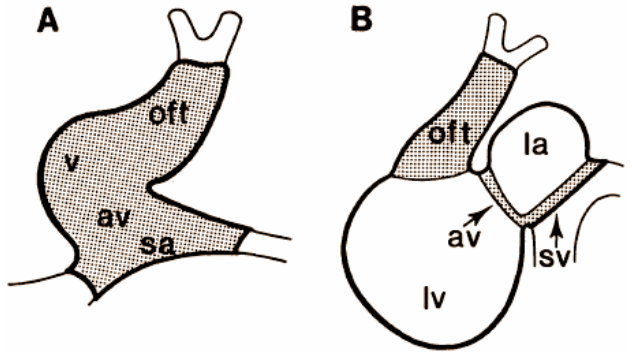
Figure 3. Slow and fast conducting regions. Alternating regions of slow and fast conduction in the looping heart of the chicken embryo detected using electrodes [38]. ( A ) The conduction velocity of the HH stage 13 (embryonic day 2) early looping heart was found to be slow and homogeneous; ( B ) This pattern changed to regions of fast conduction (white regions) alternating with regions of slow conduction (dotted regions) by HH stage 23 (embryonic day 4). oft = outflow tract, v = ventricle, av = atrioventricular junction, sa = sinoatrial junction, la = left atrium, lv = left ventricle, sv = sinus venosus.